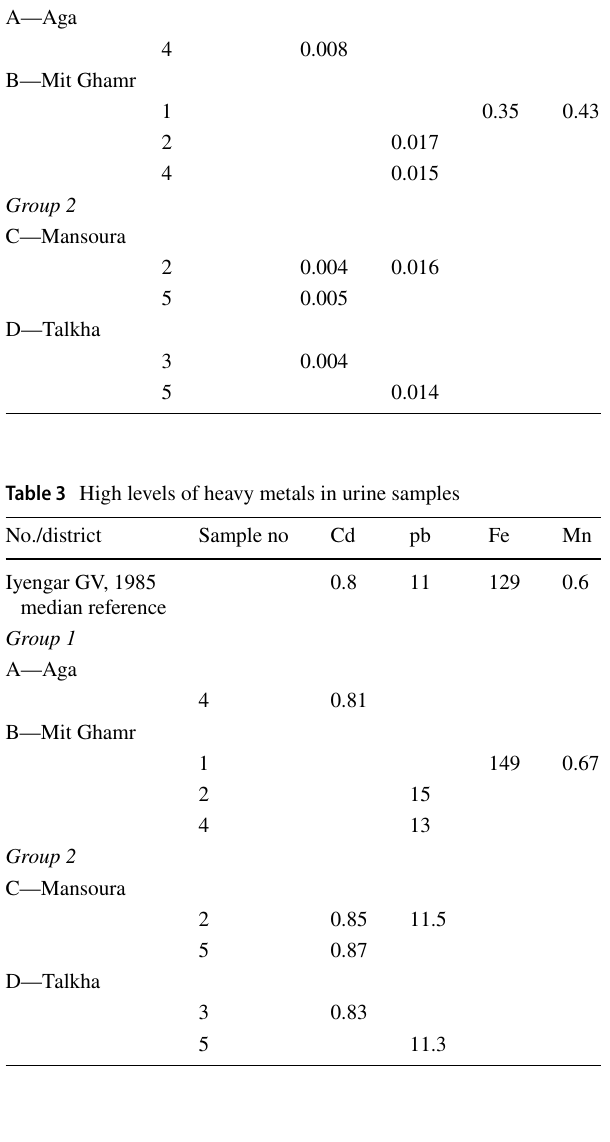
Table 4 Blood sample values expressed as mean ± SD